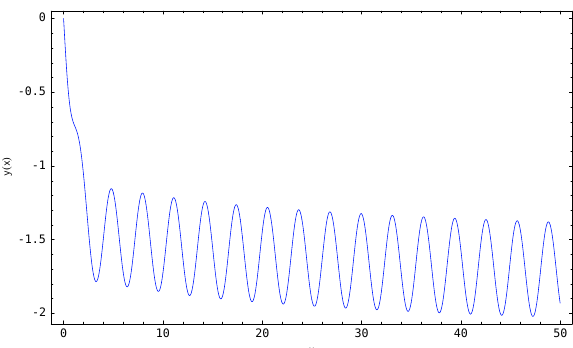
Fig. 11: Computational results of y ( x ) with h = 1 , N = 20 for α = 1.5, β = 0.5 for Example 5.